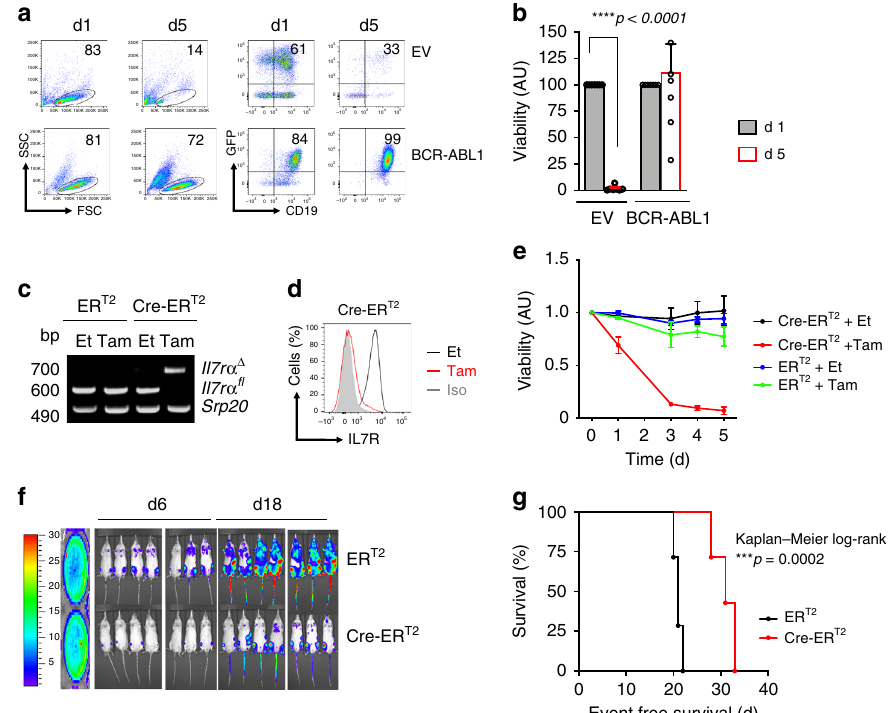
Fig. 3 IL7R is required for BCP-ALL leukemogenesis. a BM-derived pre-B cells from WT mice were transduced with either an empty vector (EV) or with BCR- ABL1. Viability of the cells after IL7 withdrawal was determined by fl ow cytometry (left). The enrichment of CD19 + GFP + (right). The results are representative of three independent experiments. b Quanti fi cation of viable CD19 + GFP + cells relative to control after IL7 withdrawal ( n = 7 per group, and error bars represent mean±SEM. Unpaired t -test, two-sided, exact p value **** p <0.000000000000001). AU arbitrary unit. c – g Il7r α fl / fl pre-B cells were transformed with BCR- ABL1 and were then transduced with either ER T2 or Cre-ER T2 . Cells were treated with either tamoxifen (Tam) to induce Cre expression, or with ethanol (Et). c PCR analysis for Il7r α deletion ( Il7r α Δ ), Srp20 was used as a loading control. Cells transduced with ER T2 were used as control. The results are representative of three independent experiments. bp base pair. d Extracellular staining for IL7R protein in Il7r α fl / fl pre-B cells after 72h of Cre-induction. The results are representative of three independent experiments. e The percentage of living cells were determined by fl ow cytometry using Sytox as an excluding dead cell stain. N = 3 independent samples per group, and error bars represent mean±SD. One-way ANAOVA. Dunnett ’ s multiple comparisons test was performed to day 5, compared with control group (ER T2 Et). Adjusted p values: ER T2 Et vs. ER T2 Tam n.s. p = 0.1769, ER T2 Et vs. Cre-ER T2 Et n.s. p = 0.6325, ER T2 Et vs. Cre- ER T2 Tam **** p <0.0001. f Luciferase bioimaging and g survival curves of NOD-SCID mice that were injected with 1×10 6 Il7r α fl / fl -BCR-ABL1 pre-B cells containing either a Cre-ER T2 construct or an ER T2 . ( n = 21 per group). Mantel – Cox-log-rank test, *** p value =